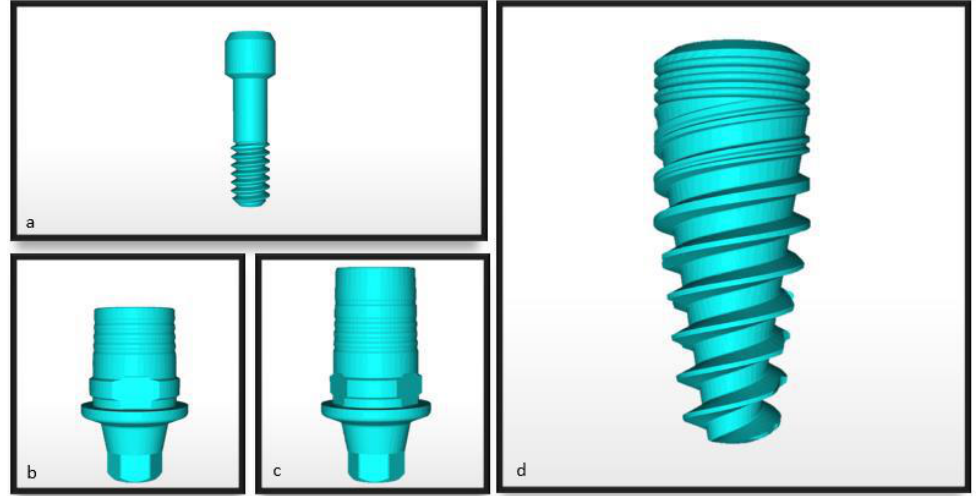
Figure 6. STL files obtained from the manufacturer (Titaniumfix, São José dos Campos, SP, Brazil); ( a ) front view of the screw; ( b ) short universal link; ( c ) long universal link; and ( d ) implant.